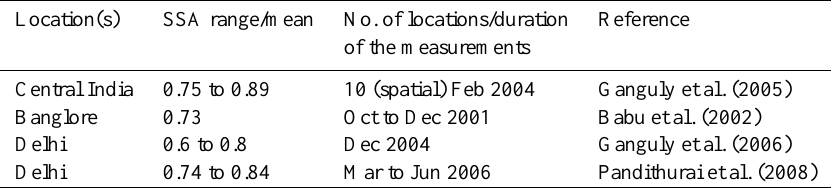
Table 1. Values of SSA over parts of India as reported in